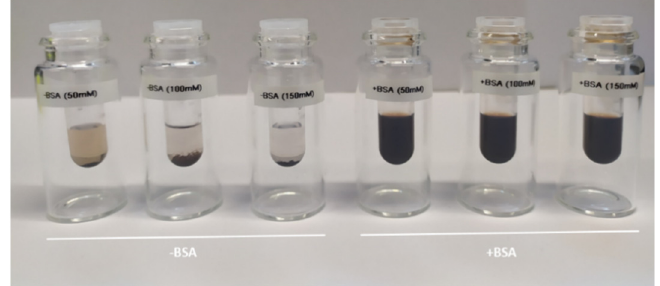
Figure 7. Visualization of colloidal stability of MNP at different saline concentrations. MNP without BSA-coating (left) and with BSA-coating. The photograph was taken one week after saline incubation at c (NaCl) = 0.05, 0.10, and 0.15 mol/L. While the uncoated MNP are almost entirely precipitated at the vial bottom, the BSA-coated MNP visually show a homogenous dispersion with no aggregation tendency.